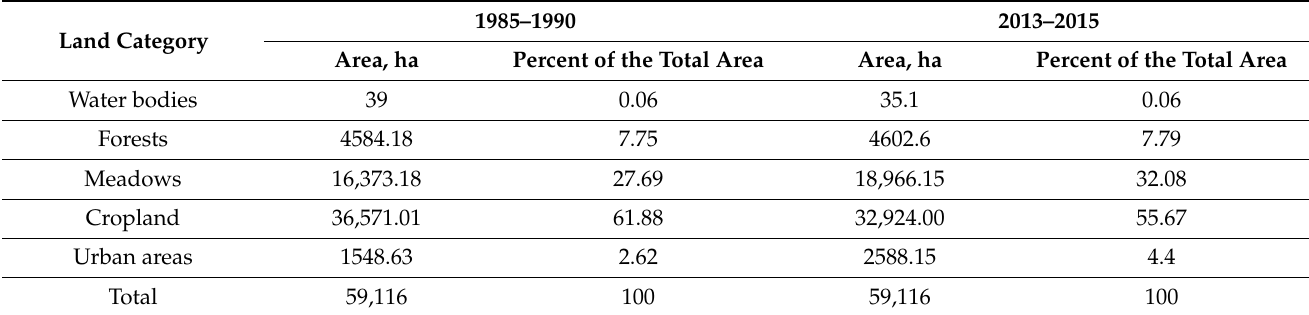
Table 4. Dynamics of land use within the test River Basin 76324 (Sterlya river